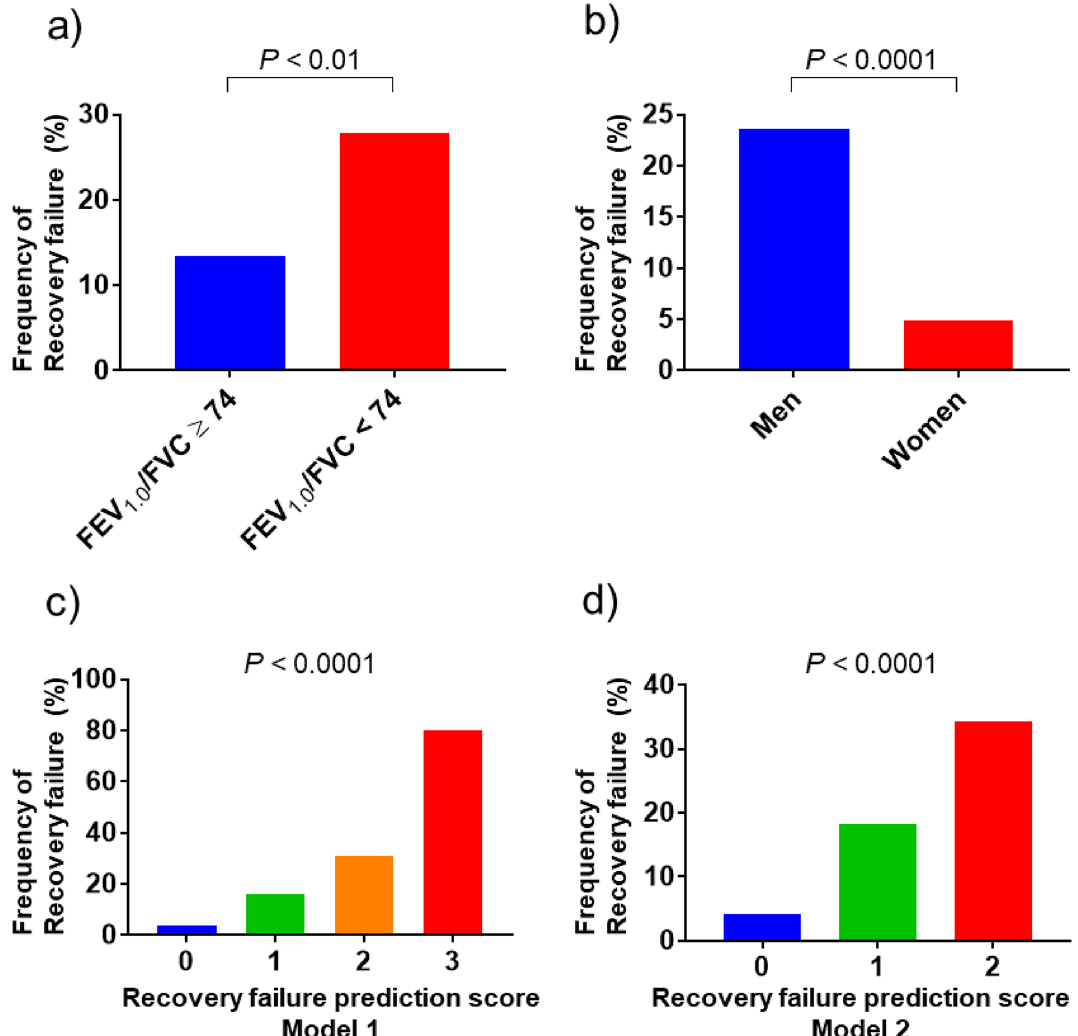
Figure 3. Predictive factors and recovery failure frequency in the derivation cohort. ( a ) The recovery failure frequency in patients who showed an FEV 1.0 /FVC < 74% was significantly higher than that in those with FEV 1.0 / FVC ≥ 74% (27.8% vs. 13.5%, respectively; P < 0.01). ( b ) The recovery failure frequency in men was significantly higher than that in women (23.6% vs. 4.9%, respectively; P < 0.0001). ( c ) In model 1, each predictor (being a man, FEV 1.0 /FVC < 74%, a BAL target site other than the RM/ LL) was assigned one point. The recovery failure frequencies in the model 1 prediction score groups (total scores 0, 1, 2, and 3) were 3.6%, 16.2%, 30.9%, and 80.0%, respectively ( P < 0.0001; c-index 0.70). ( d ) In model 2, each predictor (being a man and FEV 1.0 / FVC < 74%) was assigned one point. The recovery failure frequencies in the model 2 prediction score groups (total scores 0, 1, and 2) were 4.2%, 18.2%, and 34.3%, respectively ( P < 0.0001; c-index 0.69). FEV 1.0 , forced expiratory volume in one second, FVC forced vital